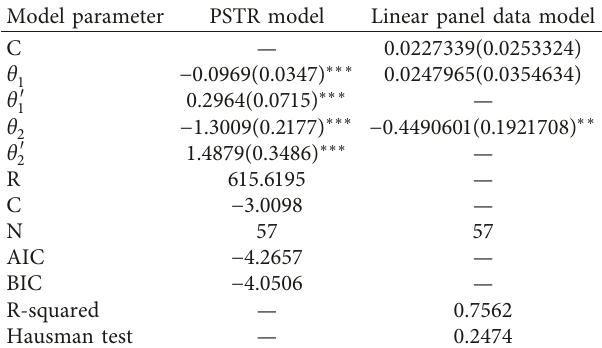
Table 9: Empirical results of PSTR and linear models. Model